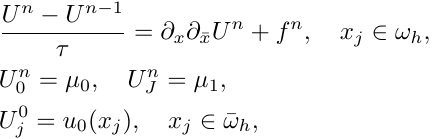
(cid:107) A are presented for different discrete 1 h